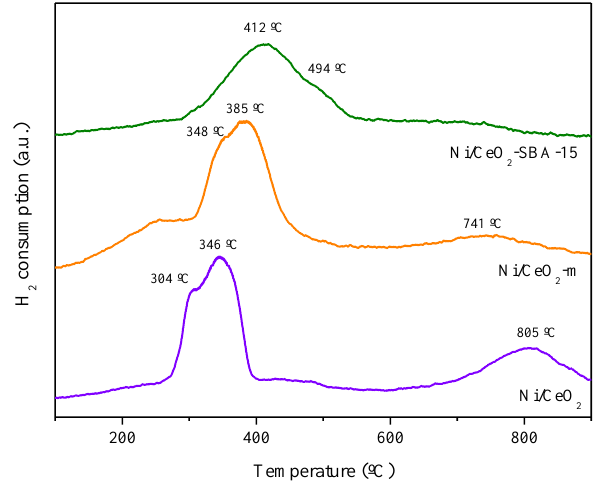
Figure 4. H 2 -TPR profiles of calcined Ni-based catalysts.